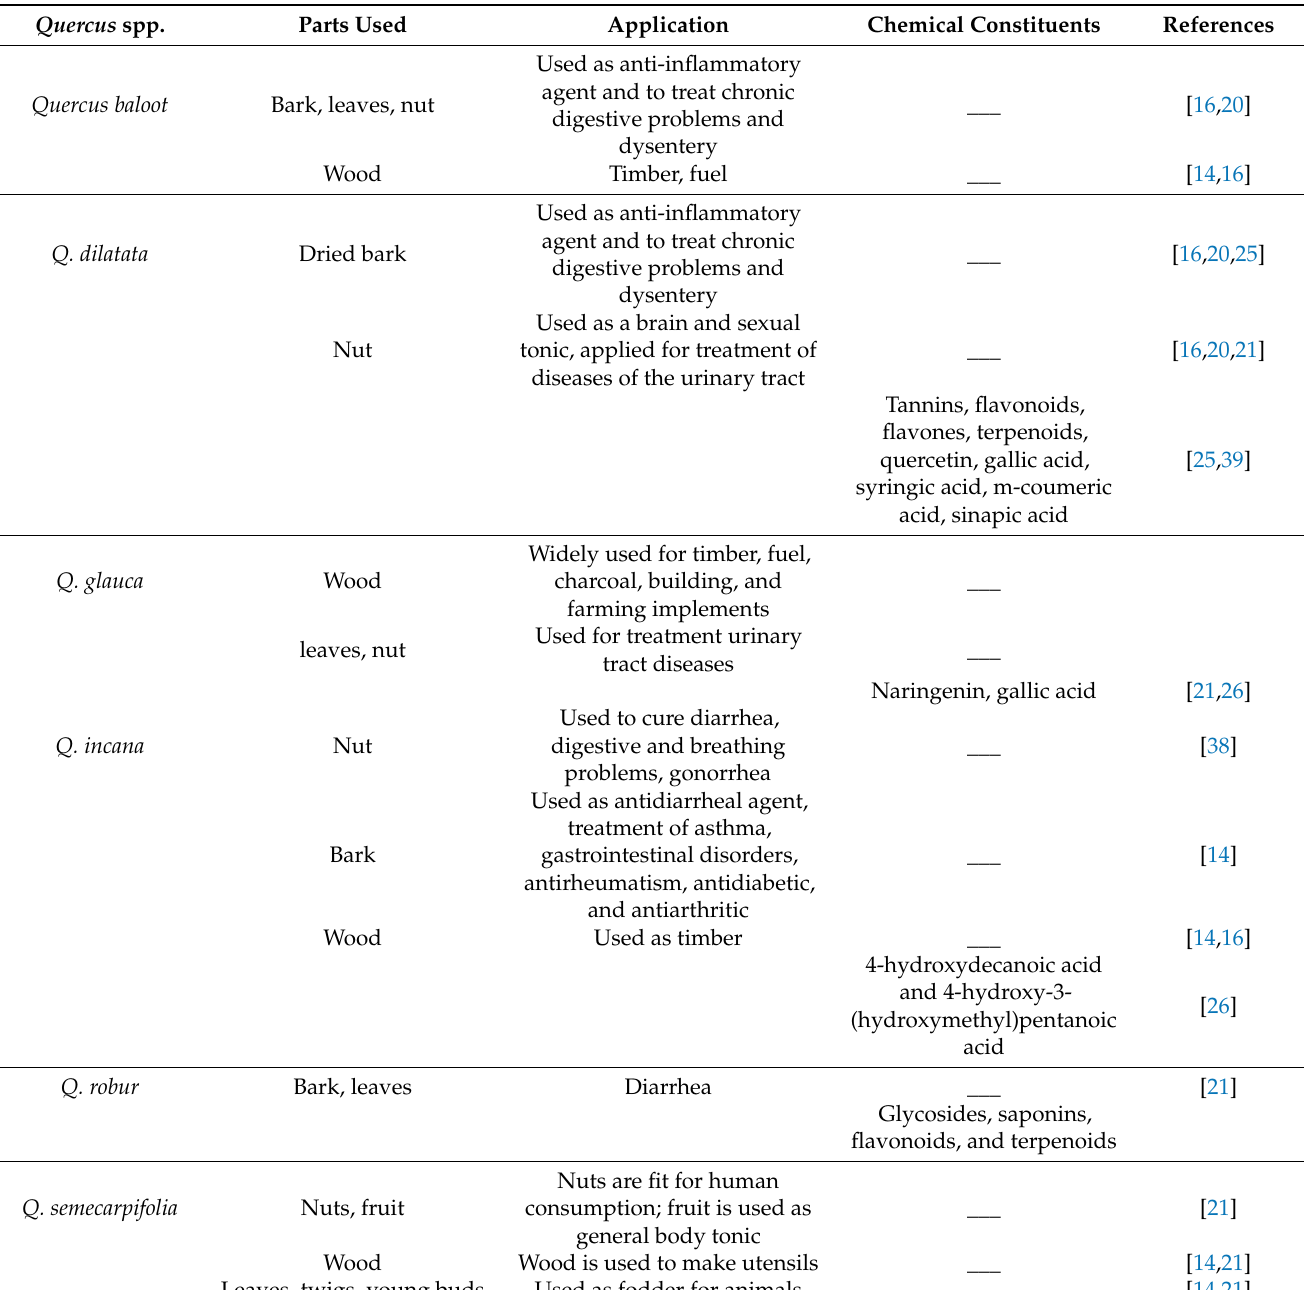
Table 2. Medicinal uses and phytochemical constituents of different organs from the Pakistani oak